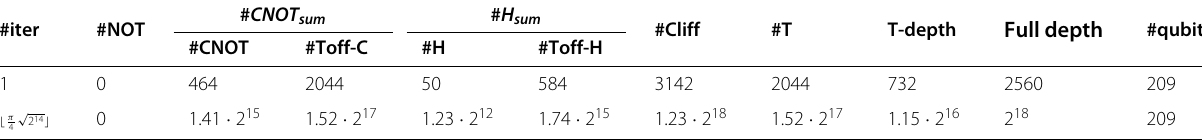
Table 7 The cost of quantum partial key guessing using D i ( i = 1, 2, 3, 4 ) in QRKR